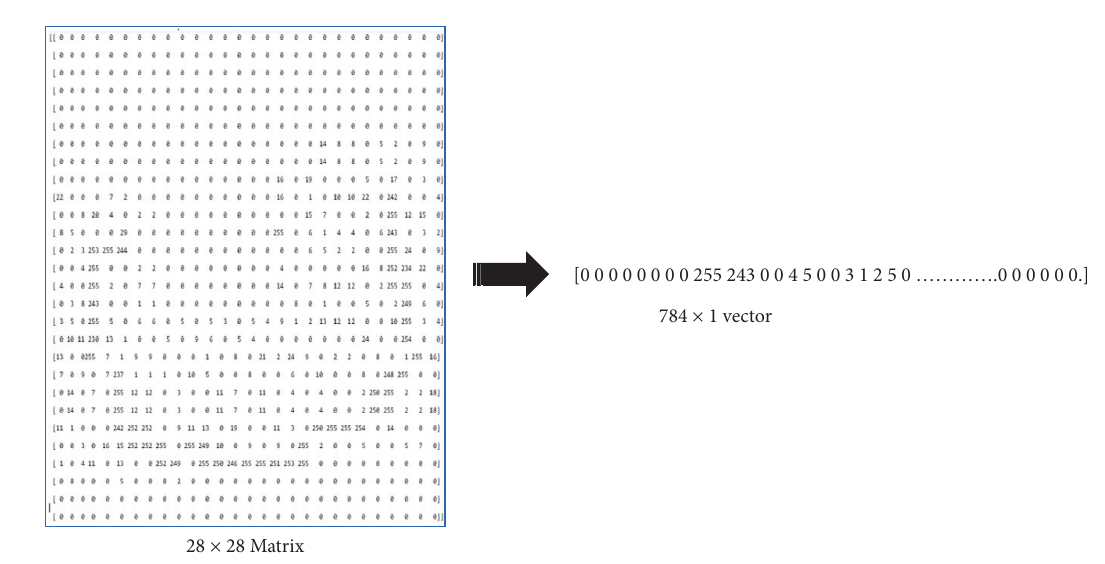
Figure 11: Row image as input to the neural network.